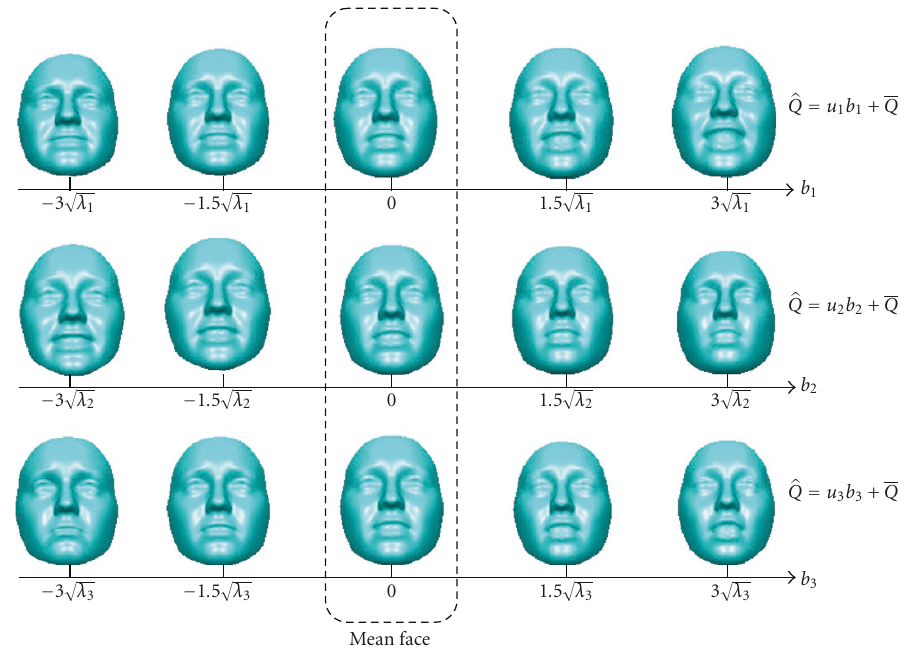
Figure 2: E ff ects of changing the contribution of the first three principal components of the shape space vector on the models derived from the FaceGen and BU-3DFE data